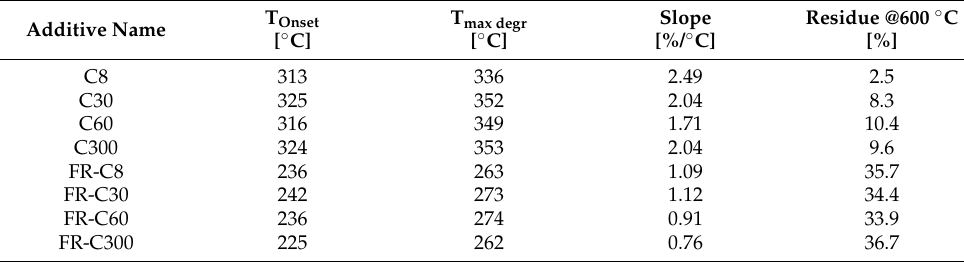
Table 6. TGA measurement data of the untreated and FR-treated cellulose additives.